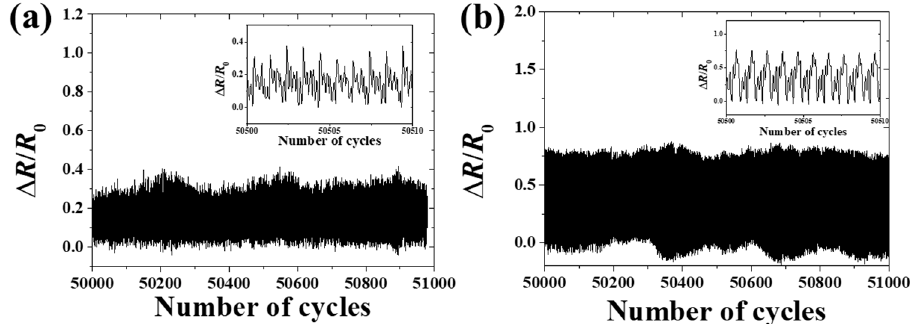
Figure 8. ( a ) The resistance change ratio of the EES under cyclic loading with the strain of 10%. ( b ) The resistance change ratio of the EES under cyclic loading with the strain of 30%.